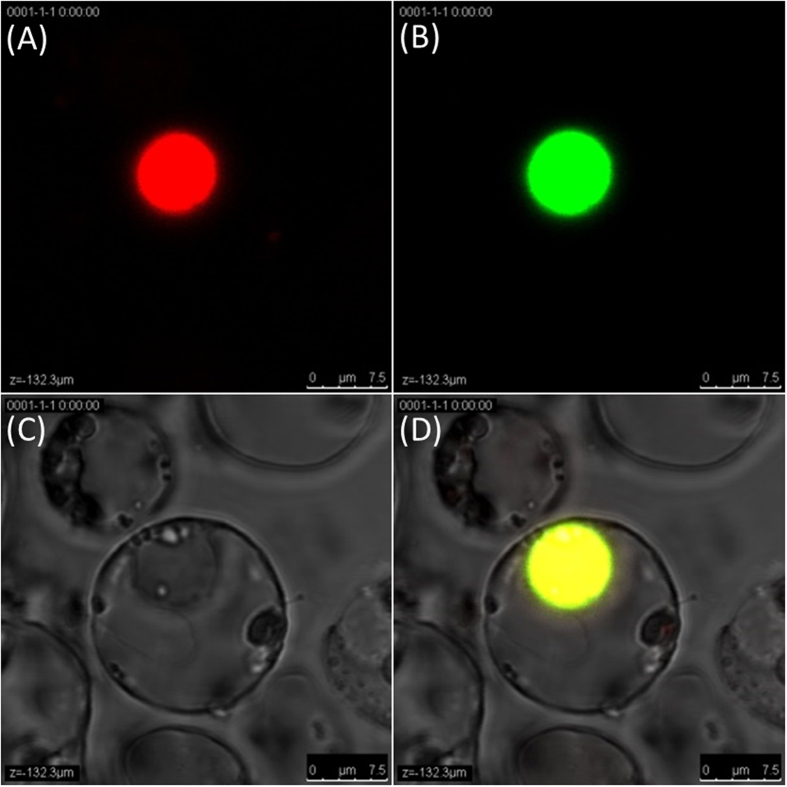
Fluorescent and bright field visualization of OsMeCP subcellular localization on the rice protoplast.The fluorescence images were acquired at 568-nm excitation and 592-nm emission using an Olympus Fluoview FV1000 laser scanning confocal microscope. Image (A) is a monomeric far-red fluorescent protein TagFP635 (scientific name mKate) that tagged the nuclear localization signal protein localized to the nucleus, and was taken as the standard marker to indicate the location of the nucleus in the rice protoplast. Image (B) is a fluorescent field visualization of OsMeCP and image (C) is the bright field visualization of the rice protoplast. Image (D) is the overlay of images (B,C) to clearly show the OsMeCP subcellular localization.